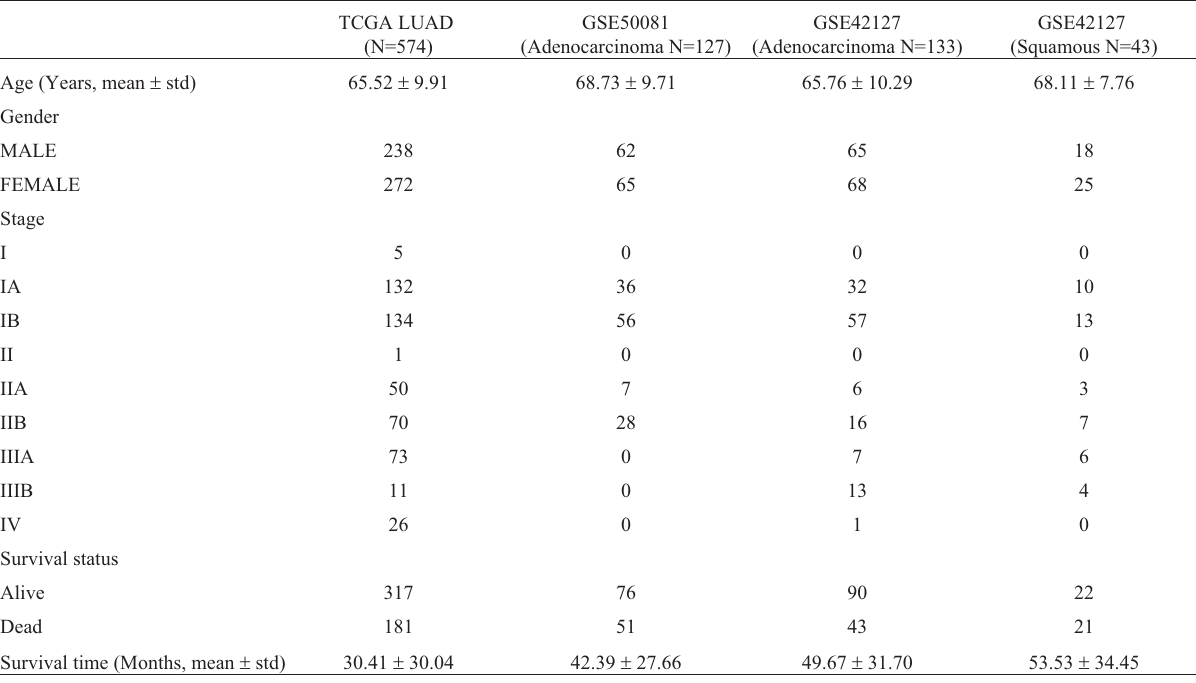
Table 2 - Characteristics of patients by the five-gene-based classifier assessment set.